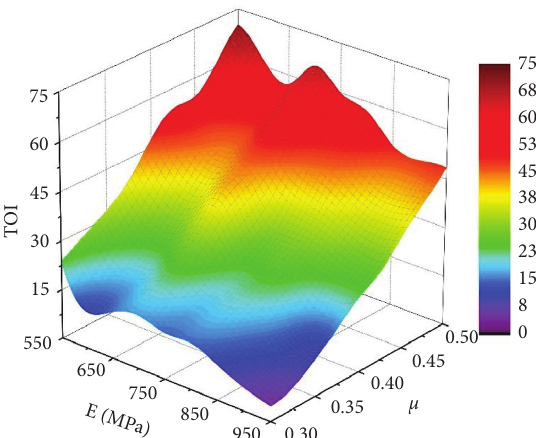
Figure 7: Indirect effects of working conditions on